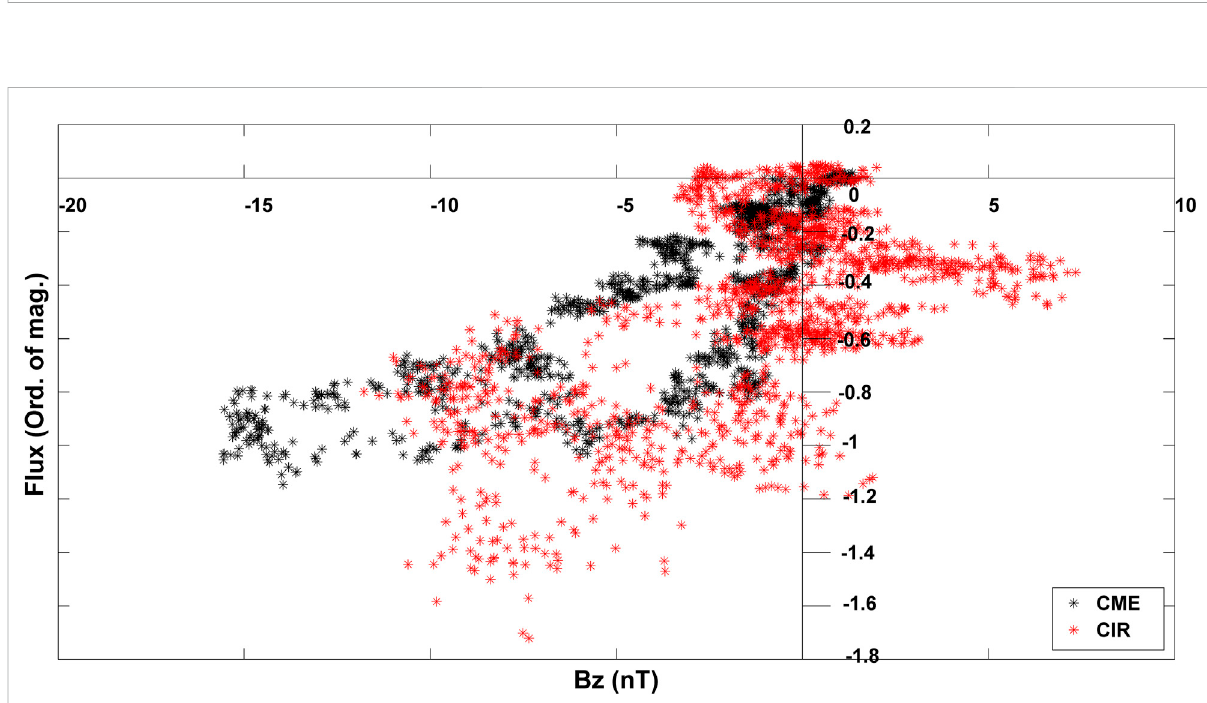
FIGURE 8 Variation of Δ F (in the order of magnitude) with IMF Bz (nT) for storms associated with CME (black) and CIR (red).